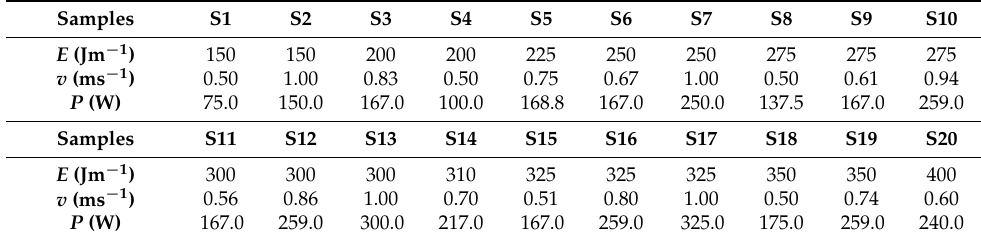
Table 3. Process parameters set (specific laser Energy E , scanning speed v and laser power P ) investigated to fabricate the 20 (twenty) cubic samples of both FeSi3 and FeSi6.5